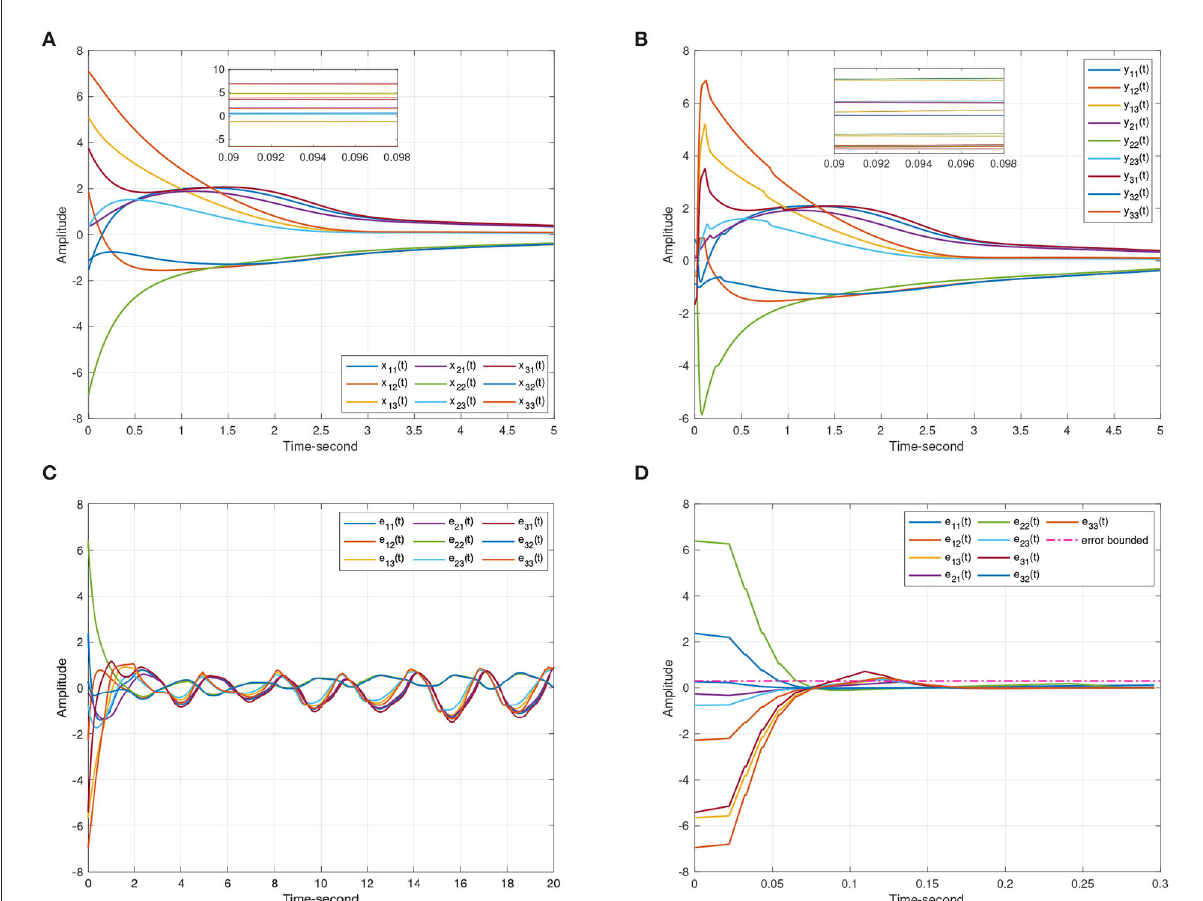
FIGURE5 The synchronization state trajectories produced by systems (8) and (9). (A) The state curves of the drive system (8). (B) The state curves of the response system (9). (C) The synchronization errors ε ( t ) event-triggered scheme